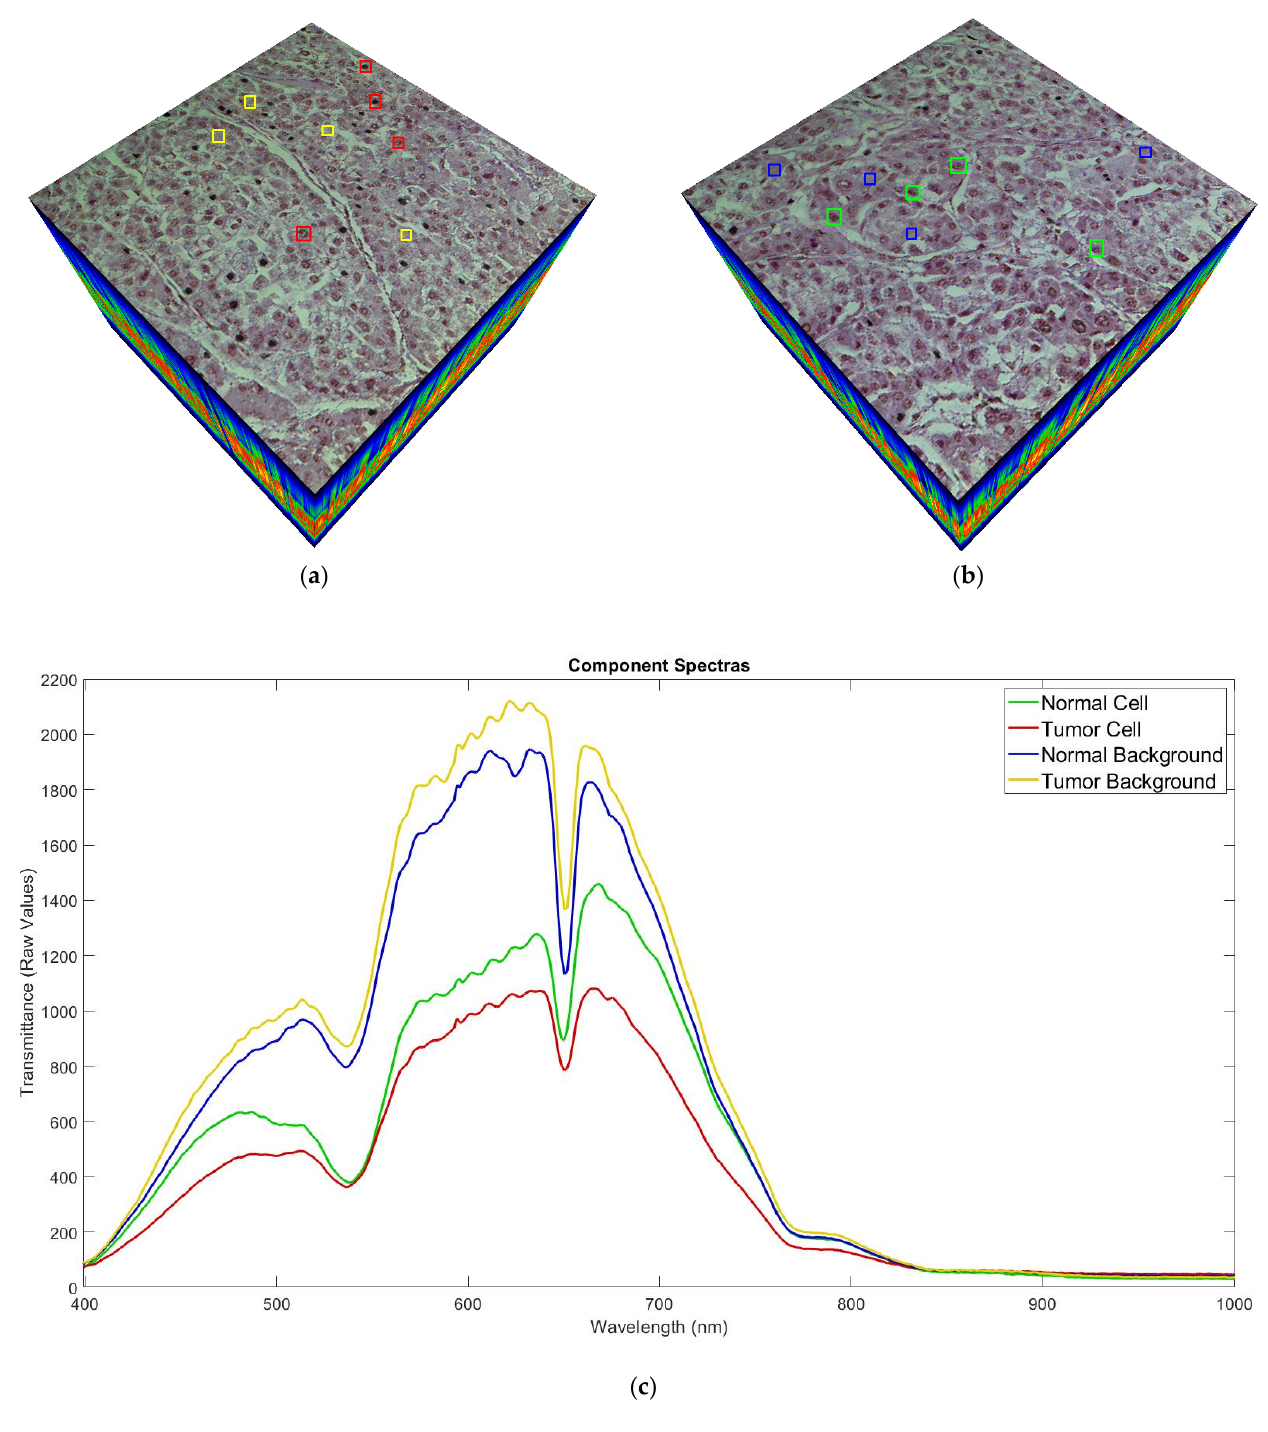
Figure 2. Hyperspectral tissue samples dataset. ( a ) Tumor (hepatocellular carcinoma, HCC) tissue sample, tumor cells (red), tumor background tissue (yellow); ( b ) Normal (Healthy) tissue sample, normal cells (green), normal background tissue (blue); ( c ) Spectra comparison plotting of the given components.